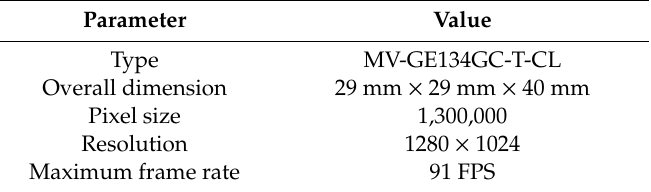
Table 4. The parameters in the 3D laser vision system.